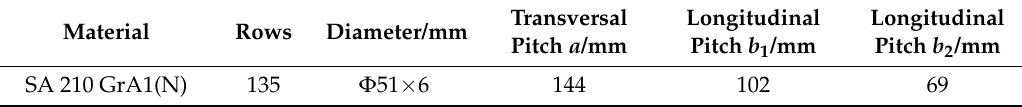
Table 1. Structural parameters of the economizer tube [25].